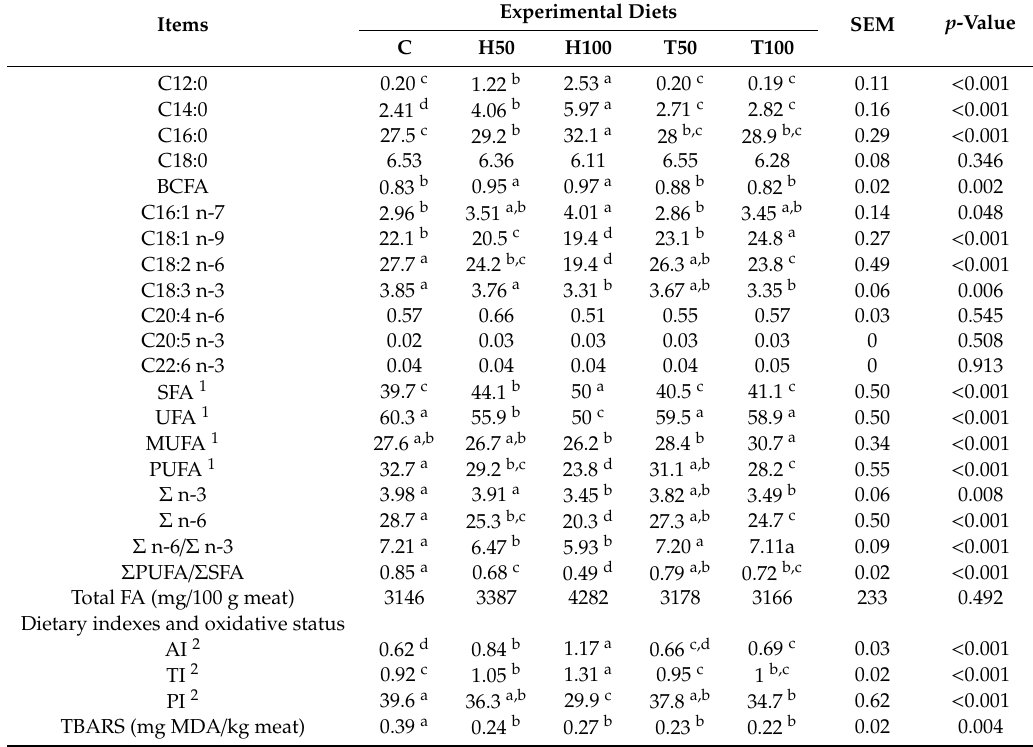
Table 5. E ff ect of the experimental diets on the fatty acid profile (% of total FAME), dietary indexes and oxidative status (TBARS, mg MDA / kg of meat) of Longissimus thoracis et lumborum muscle of rabbits (n = 15 rabbits /